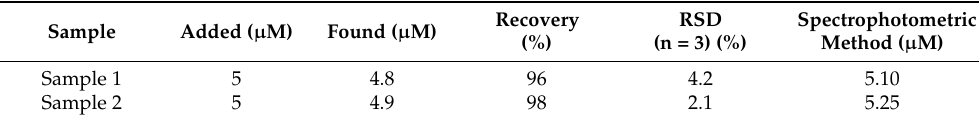
Table 4. Determination of DA in urine samples (n = 3) using the calibration curve from Figure 6.